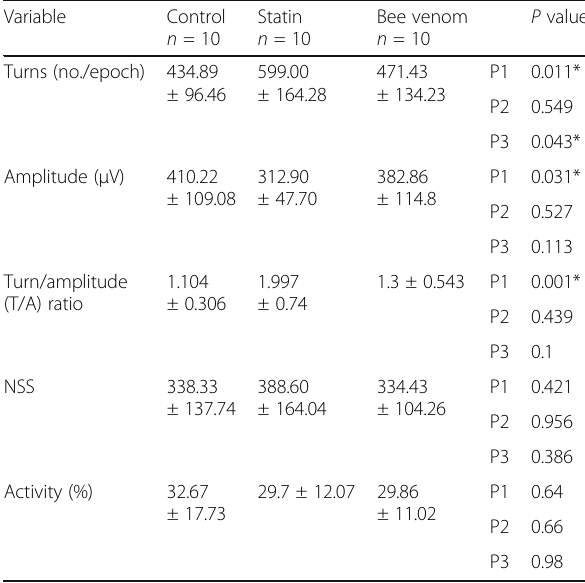
Table 2 Interference pattern analysis parameters of the gastrocnemius muscle Variable